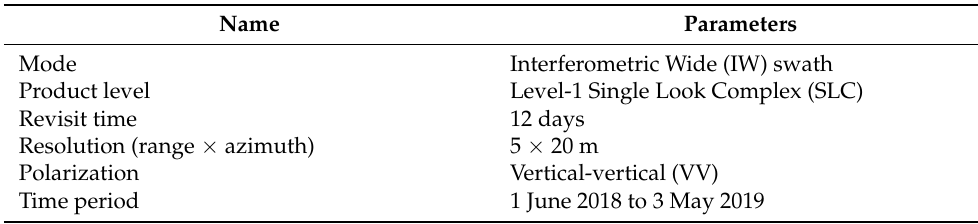
Table 1. Sentinel-1 B